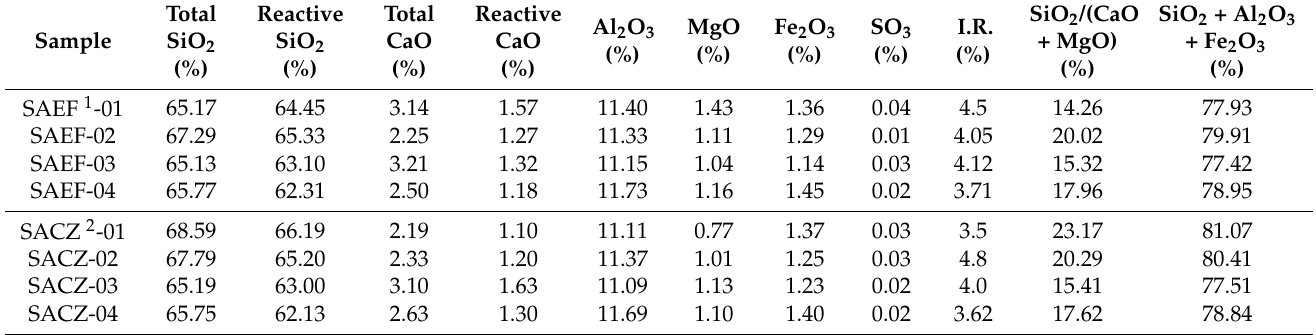
Table 4. Chemical characterisation to determine the pozzolanic quality of the researched